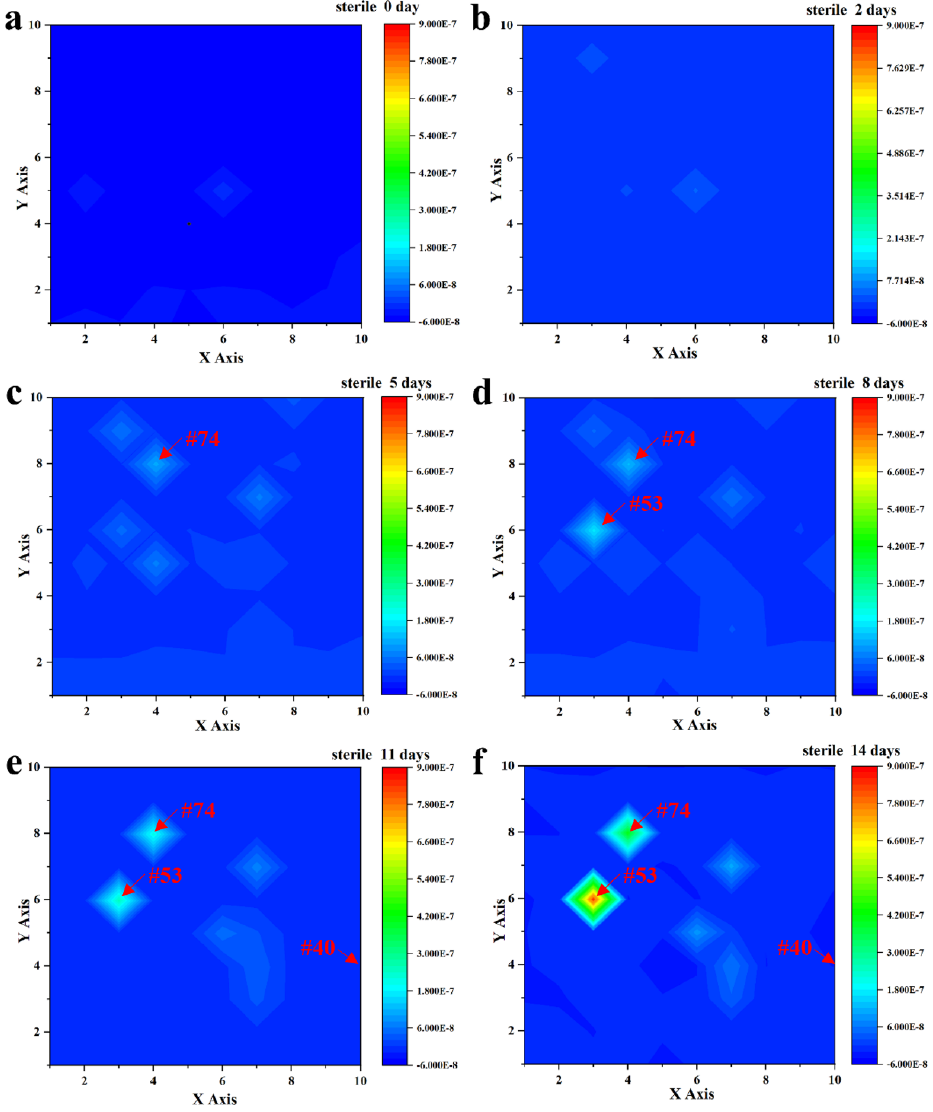
Figure 3. Current density distribution of the entire WBE surface after the immersion in a sterile liquid medium for 0 days ( a ), 2 days ( b ), 5 days ( c ), 8 days ( d ), 11 days ( e ), and 14 days ( f